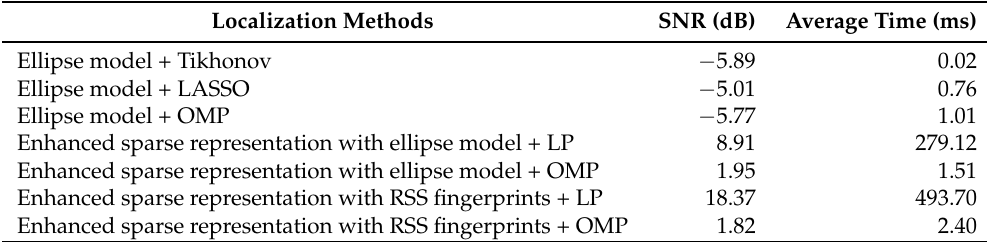
Table 2. Comparison of average SNR and time consumption in the indoor LOS